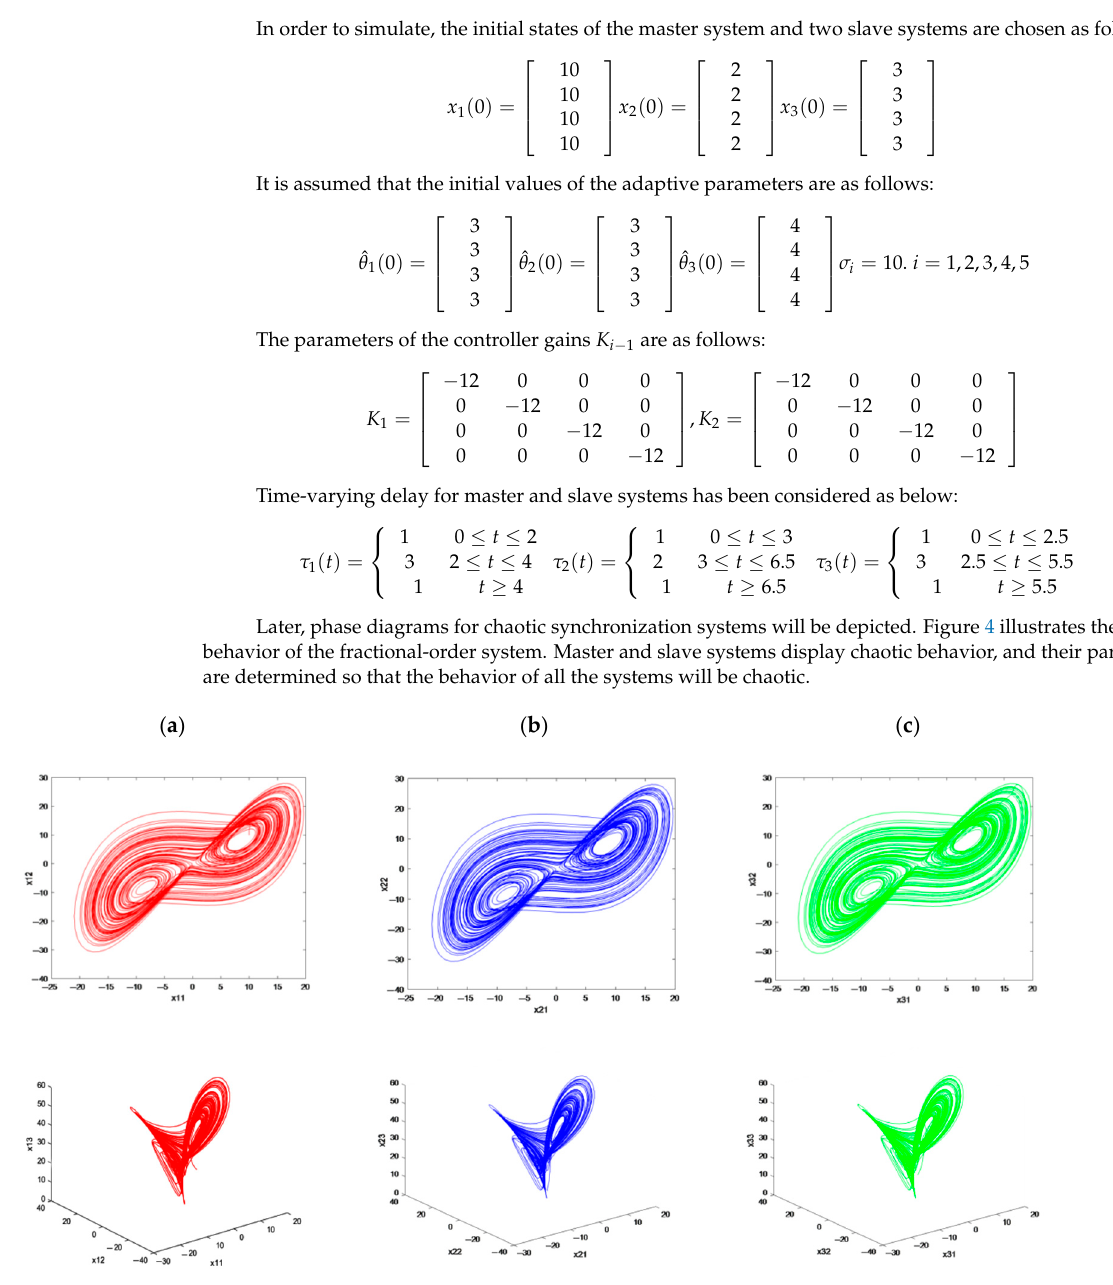
Figure 4. Phase diagrams for master and slave systems. ( a ) Master System, ( b ) slave System 1, ( c ) Figure-4. Phase diagrams for master and slave systems.( a ) Master System, ( b ) slave System 1, ( c ) slave system slave system 2.